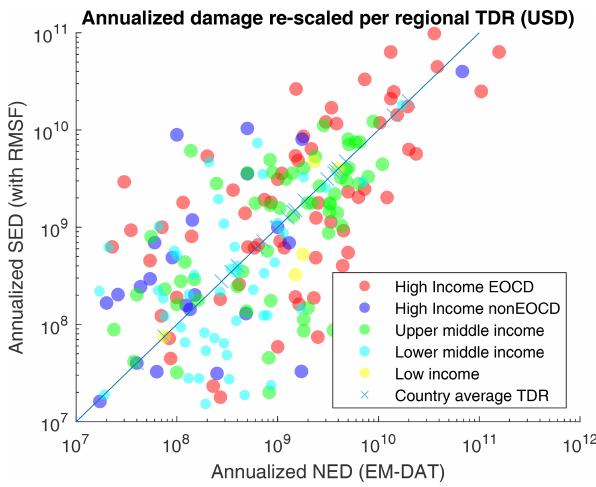
Figure 20. Estimated (RMSF) vs. reported damage (USD). The filled dots represent individual year–country pairs with re- ported damage in EM-DAT. This distribution is obtained using a 0.25 × 0.25 resolution projection. Crosses correspond to country averages (over all